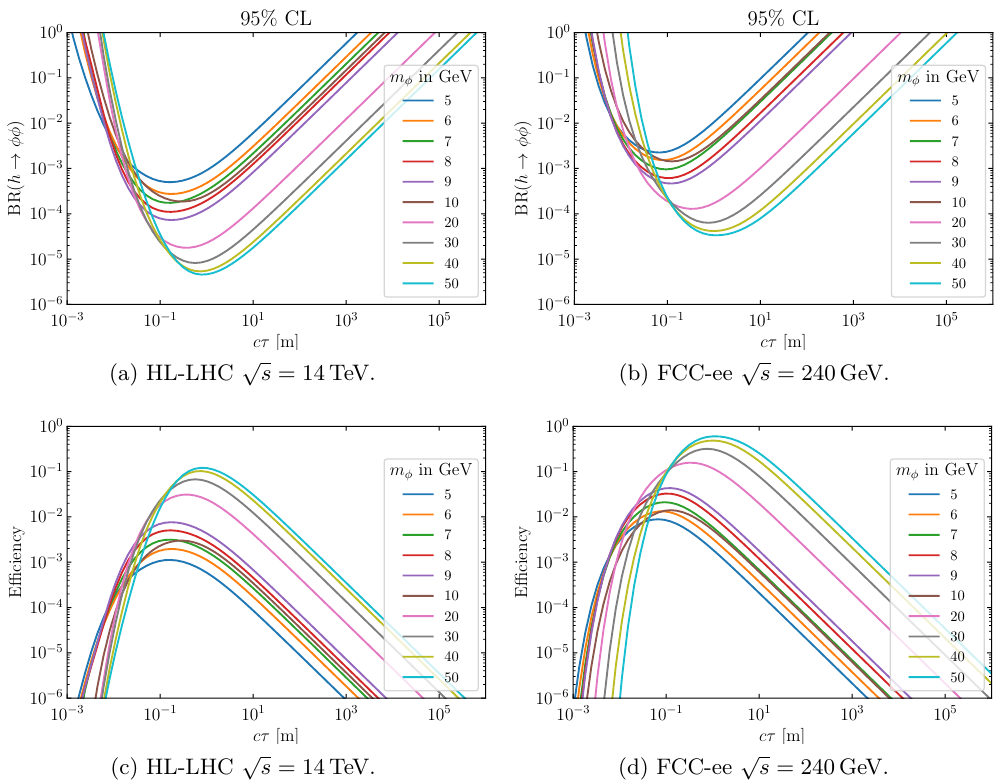
√ (c) HL-LHC s = 14 TeV. (d) FCC-ee Figure 12 . BR ( h → φφ ) and efficiency as a function of cτ φ for a search for delayed jets.